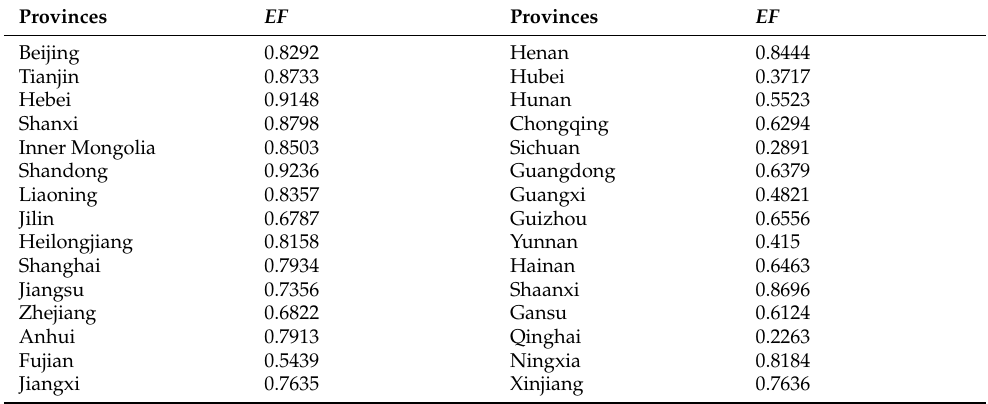
Table 3. Average CO 2 emission factor of power grids in different regions of China (kgCO 2 /kWh).